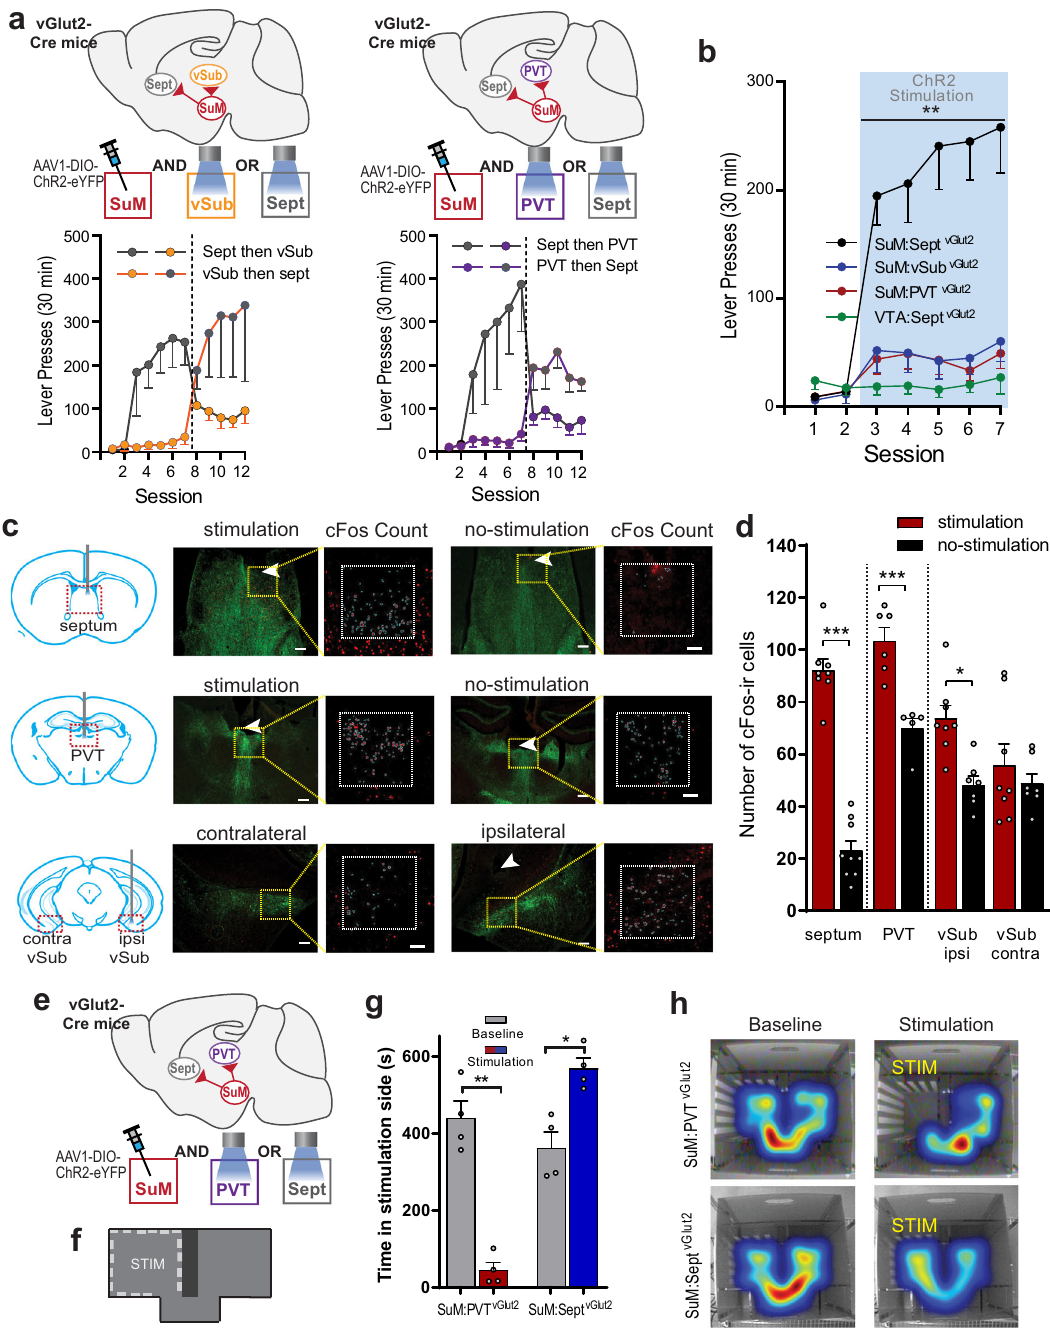
(Fig. 3c; one-way RM ANOVA, F(2,22) = 16.04, p < 0.005).